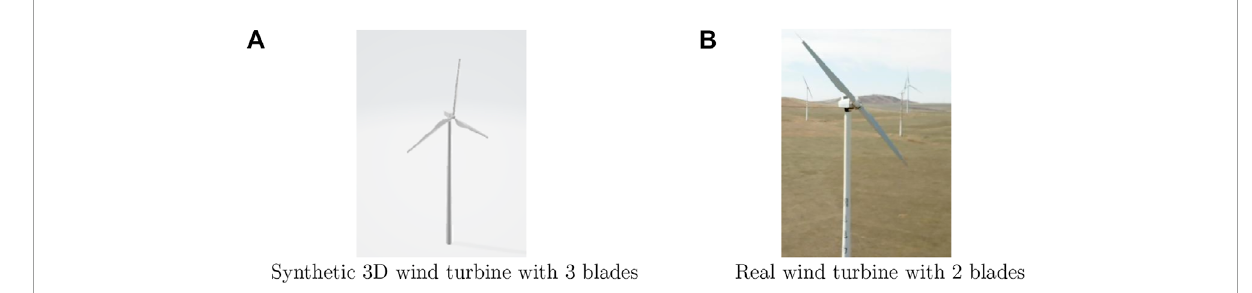
FIGURE 6 The mismatch of real wind turbine and synthetic 3D model. (A) Synthetic 3D wind turbine with 3 blades (B) Real wind turbine with 2 blades.